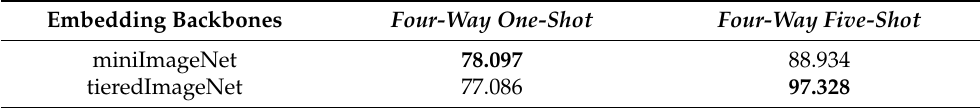
Table 5. Comparison results on different benchmark datasets: miniImageNet vs. tieredImageNet (%) (the best results in bold).